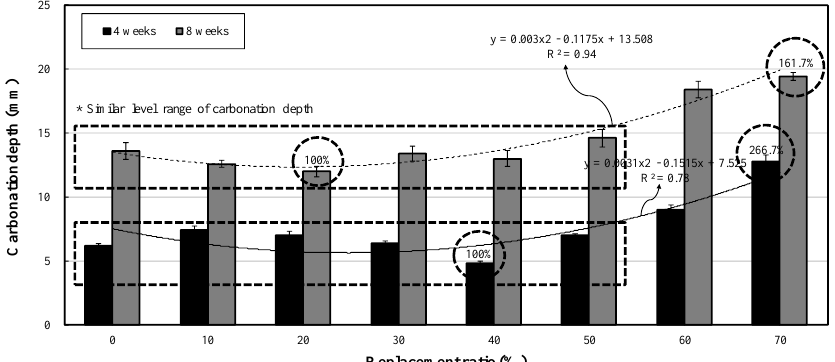
Figure 13. Carbonation depth ratio with respect to replacement ratio.